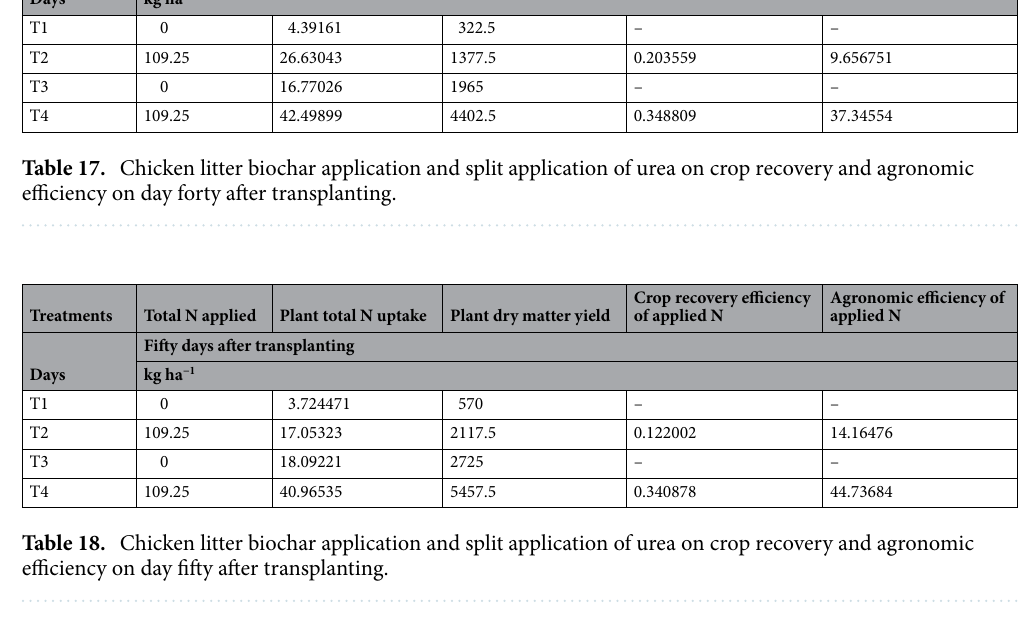
Treatments Days